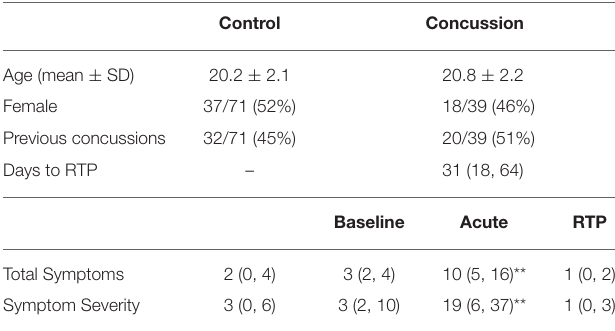
TABLE 1 | Demographic data for athletes with concussion and controls, along with symptom scores, based on the sport concussion assessment tool